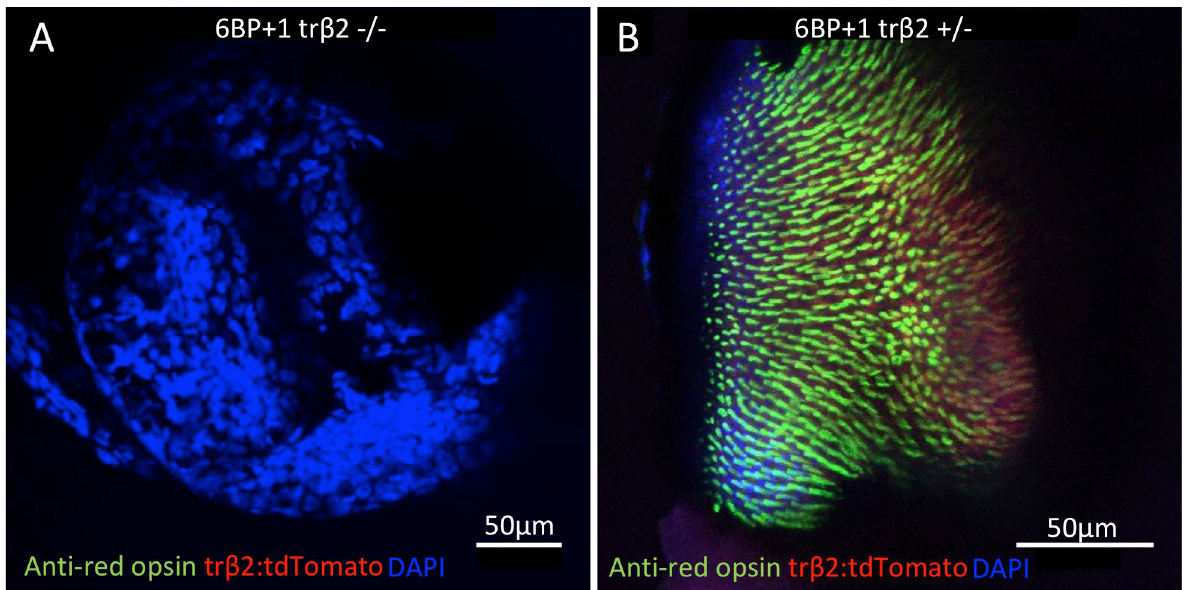
Fig 3. Antibody stains of 7 dpf larval retinas. (A) Mutant retina did not have anti-red-opsin or tr β 2 reporter fluorescence (N = 4). (B) Heterozygote retina showed the red opsin staining colocalized with tdTomato (N = 4). Images are taken from flattened retinas with the cone outer segments facing upward and in primary